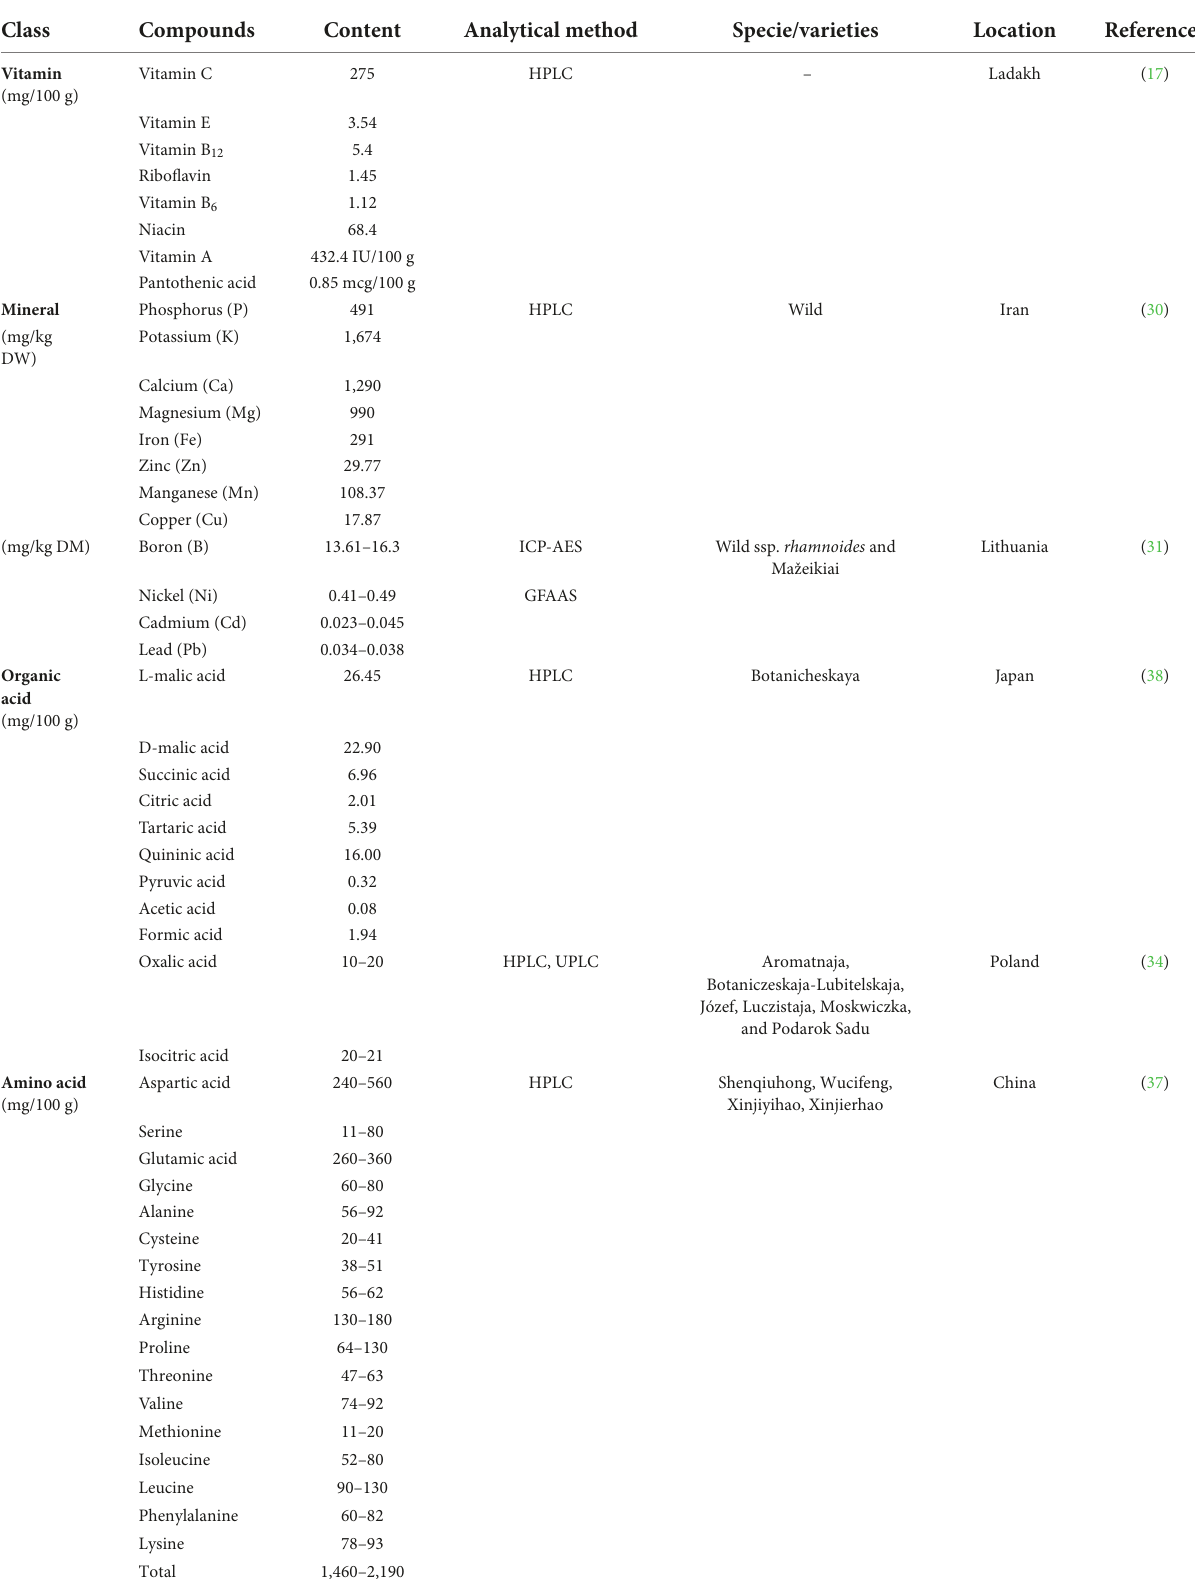
TABLE 2 Nutrients in sea buckthorn